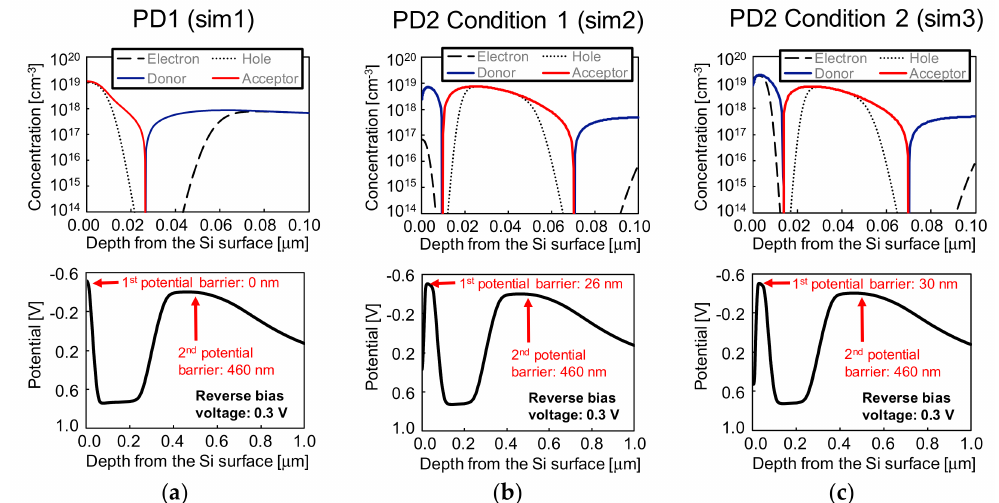
Figure 8. Simulation results for the acceptor, donor, electron and hole concentrations ( top ) and potential diagram ( bottom ) for ( a ) PD1, ( b ) PD2 in the case of full depletion and ( c ) PD2 in the case of partial depletion of the surface N + layer.